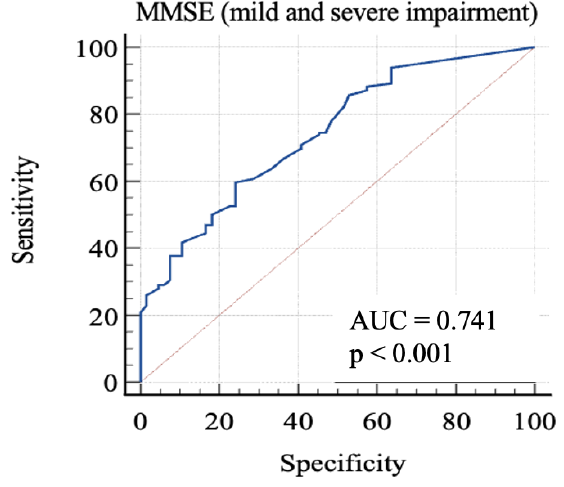
Figure 4. AUC (mild and severe impairment). MMSE, Mini-Mental State Examination; AUC, area under the ROC curve. Table 5. Criterion values and coordinates of the ROC curve (mild and severe impairment).